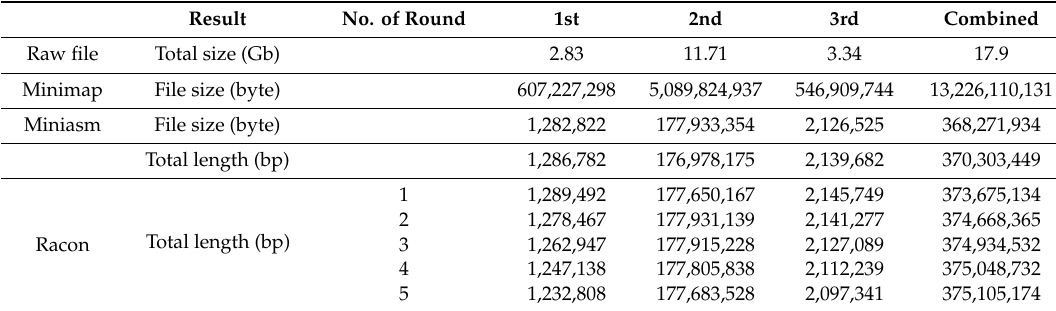
Table 4. Summary of Miniasm assemblies with Minimap and